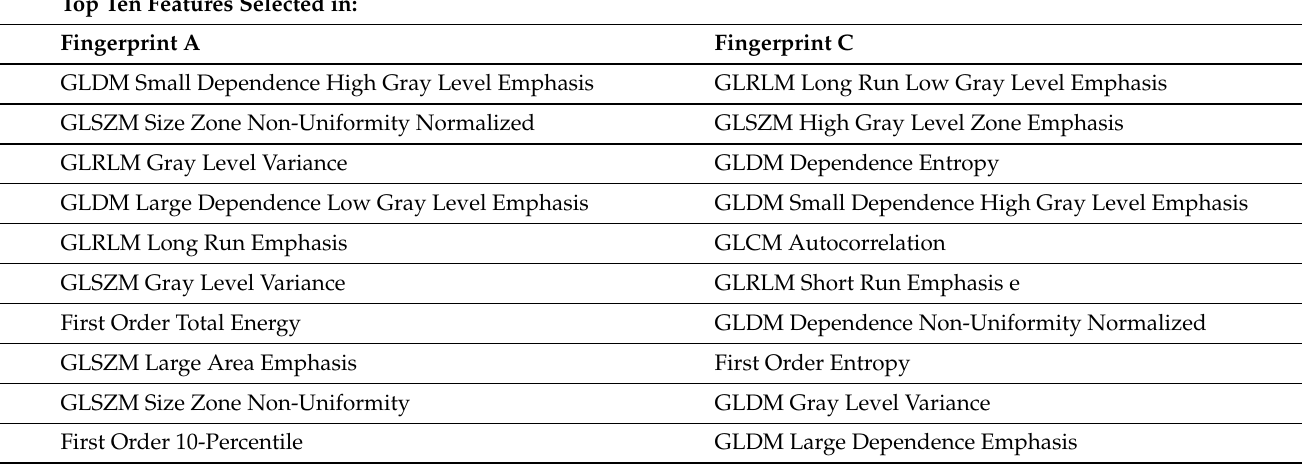
Table 4. Features selected for Fingerprint A and C. Key— SUV (standardized uptake value) , GLDM ( Gray-Level Dependence Matrix ), GLCM ( Gray-Level Co-Occurrence Matrix ), GLRLM ( Gray-Level Run Length Matrix ), and GLSZM ( Gray-Level Size Zone Matrix ).